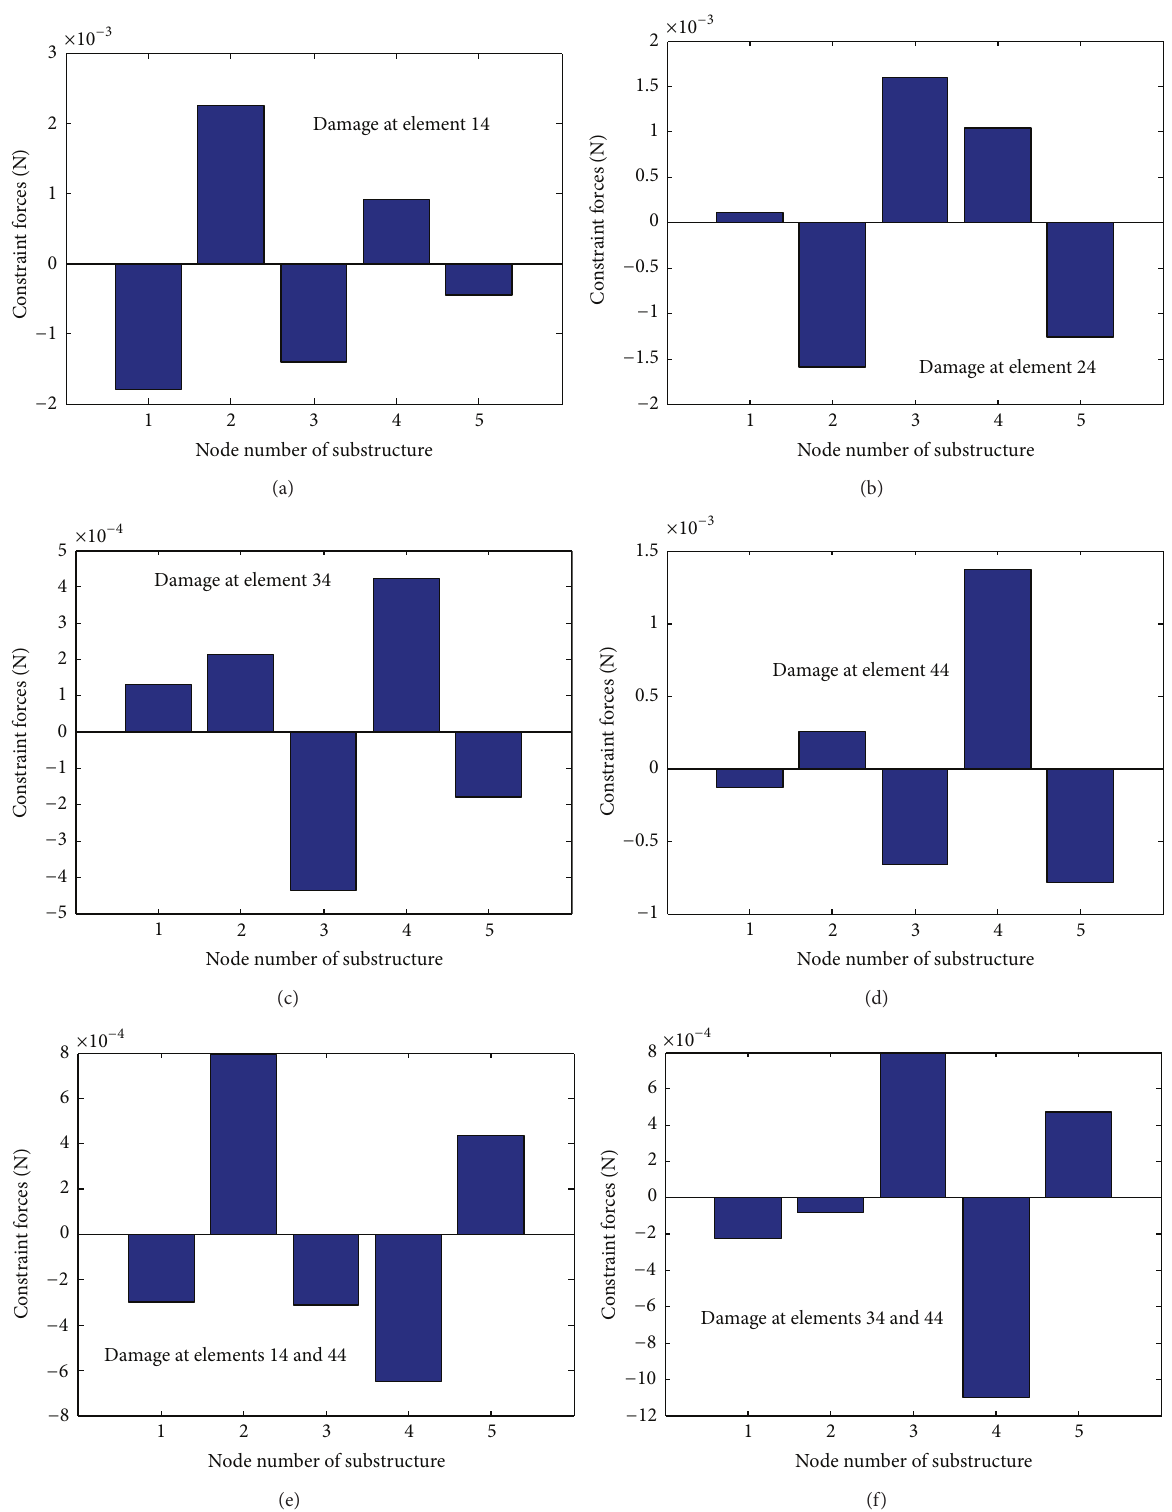
Figure 7: Constraint forces (1% noise): (a) damage at element 14, (b) damage at element 24, (c) damage at element 34, (d) damage at element 44, (e) damage at elements 14 and 44, and (f) damage at elements 34 and